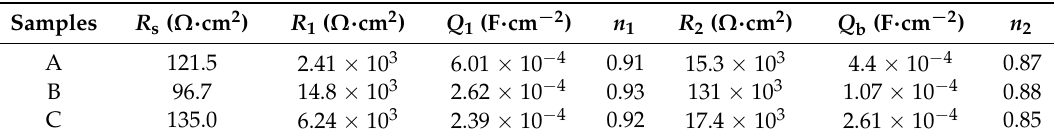
Table 4. Values of equivalent circuits obtained by Al-Swayih